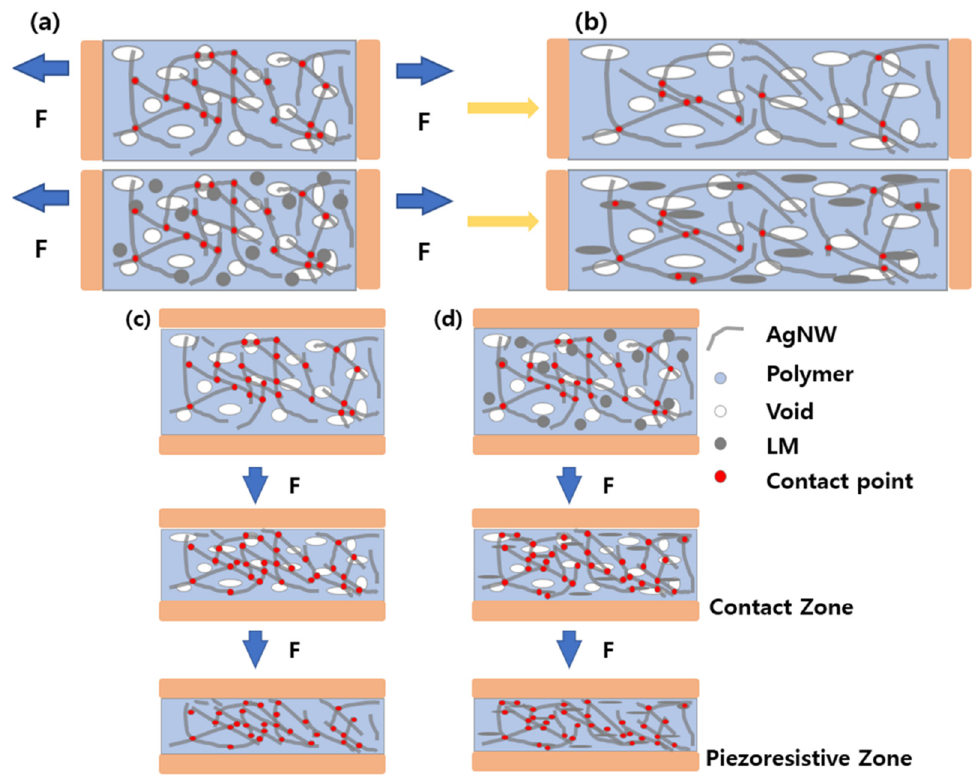
Figure 6. Schematic illustration of both types of sponge sensors. Internal view under applied tension of ( a ) PDMS/AgNW; ( b ) LM/PDMS/AgNW sensor and applied pressure of ( c ) PDMS/AgNW; ( d ) LM/PDMS/AgNW sensor.